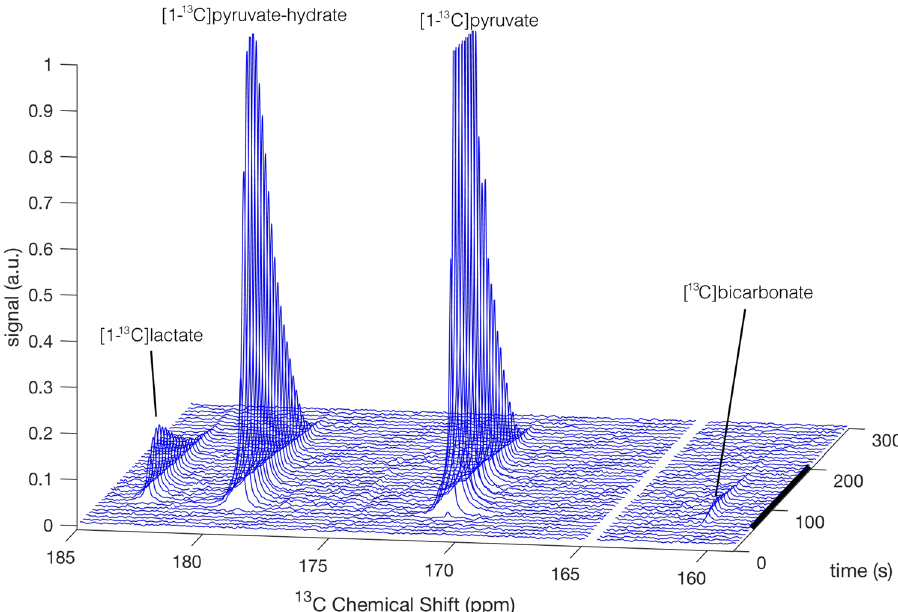
Figure 2. A typical example of hyperpolarized [1- 13 C]pyruvate metabolic conversion in cerebrum slices over the time course of one recording, shown as a stack plot of 13 C NMR spectra. The [1- 13 C]lactate, [1- 13 C]pyruvate- hydrate, and [1- 13 C]pyruvate signals were obtained with one product selective pulse and the [ 13 C]bicarbonate and [1- 13 C]pyruvate signals with a consecutive product selective pulse. The two pulses were consecutively applied throughout the measurement using an interleaved pulse sequence. For demonstrative purpose we combined the spectra of both interleaved pulses into one stacked 3D plot and omitted the [1- 13 C]pyruvate signal from the [ 13 C]bicarbonate spectra. The [1- 13 C]pyruvate and [1- 13 C]pyruvate-hydrate signals were truncated to allow dynamic range for visibility of the [ 13 C]bicarbonate signal. The black bar on the right indicates the duration of constant concentration of hyperpolarized [1- 13 C]pyruvate in the hyperpolarized media perfusing the